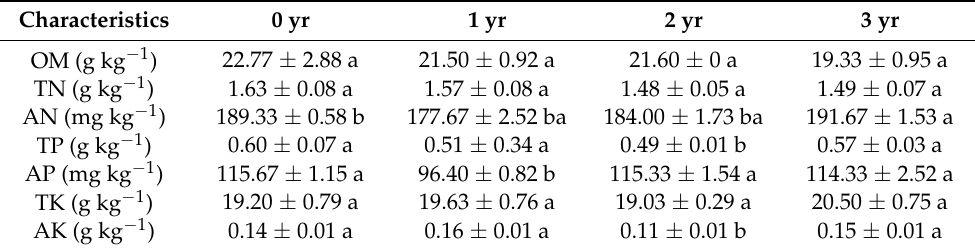
Table 1. The physical and chemical properties of the soils with different monoculture history of American